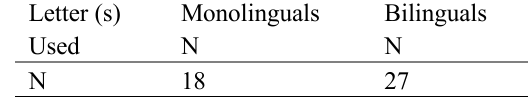
Table 16. Misspellings for the phoneme / n / in rejune Letter (s) Used